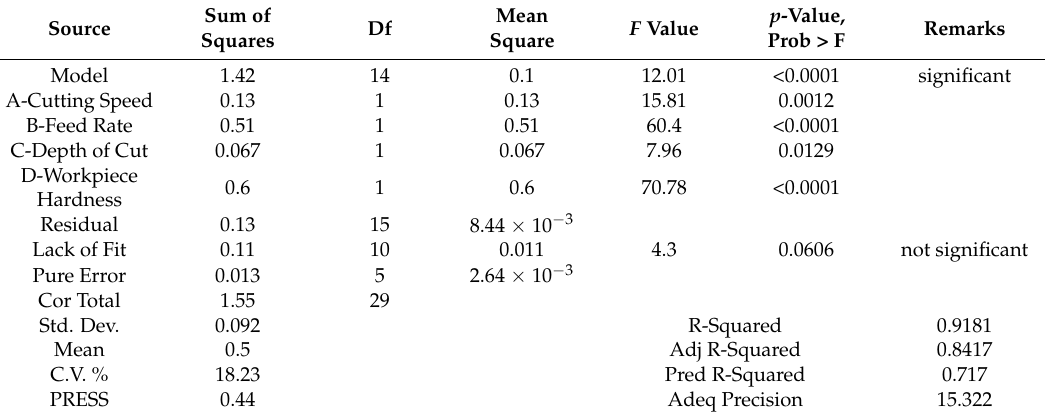
Table 5. ANOVA model of Surface Roughness for CBN-I Insert.